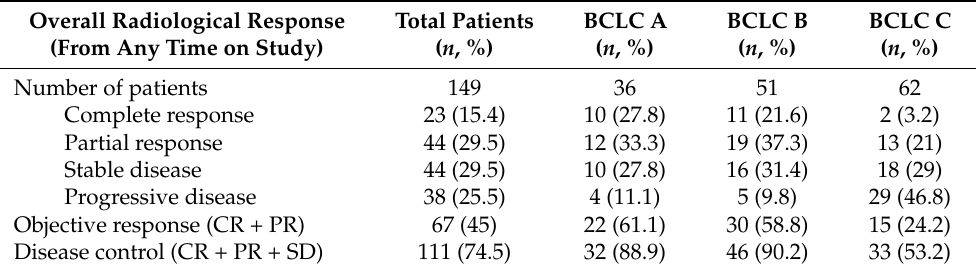
Table 2. Best overall response of